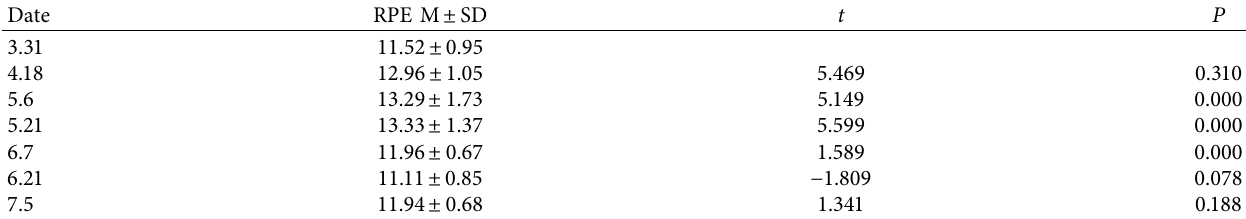
Table 2: Difference test table before and after RPE